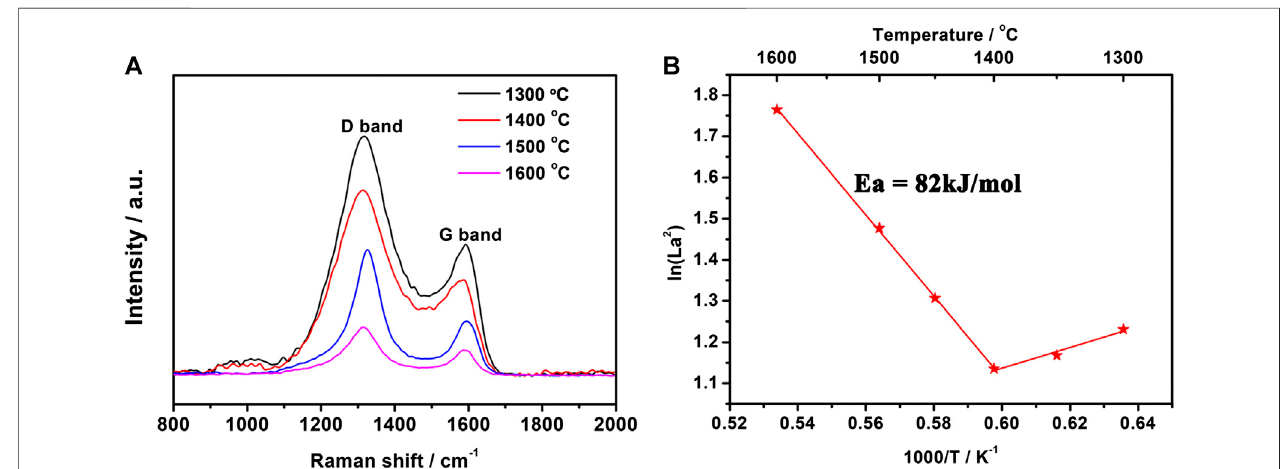
FIGURE 1 | Raman spectra of SiCN fi bers after annealing at different temperatures (A) ; the plots of L a vs. 1,000/ T (B) .